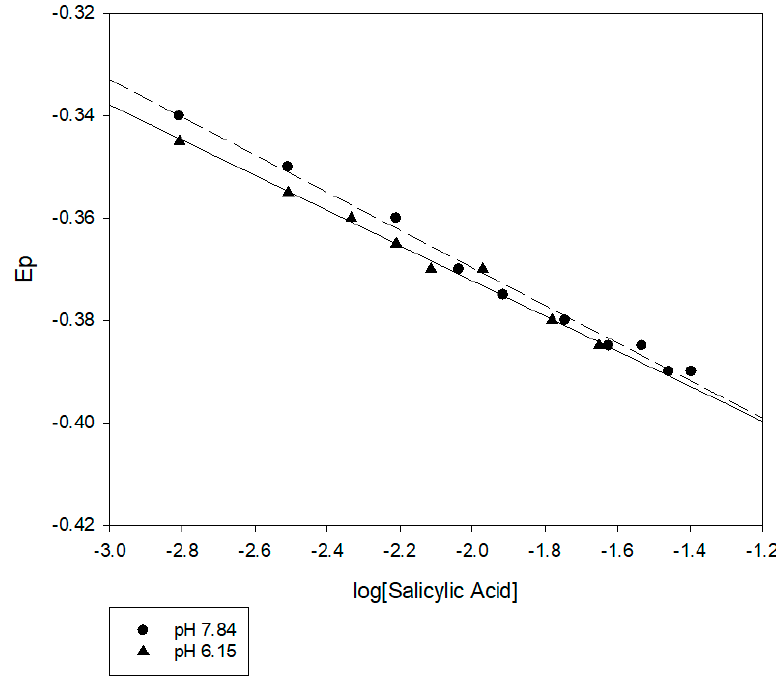
Figure 1. Di ff erential pulse polarography (DPP) results for the reduction of Pb 2 + in the presence of 1.25 mM 3,4-dihydroxybenzoic acid at three di ff erent pH values. The peak maximum (E p ) becomes increasingly negative as the pH increases.